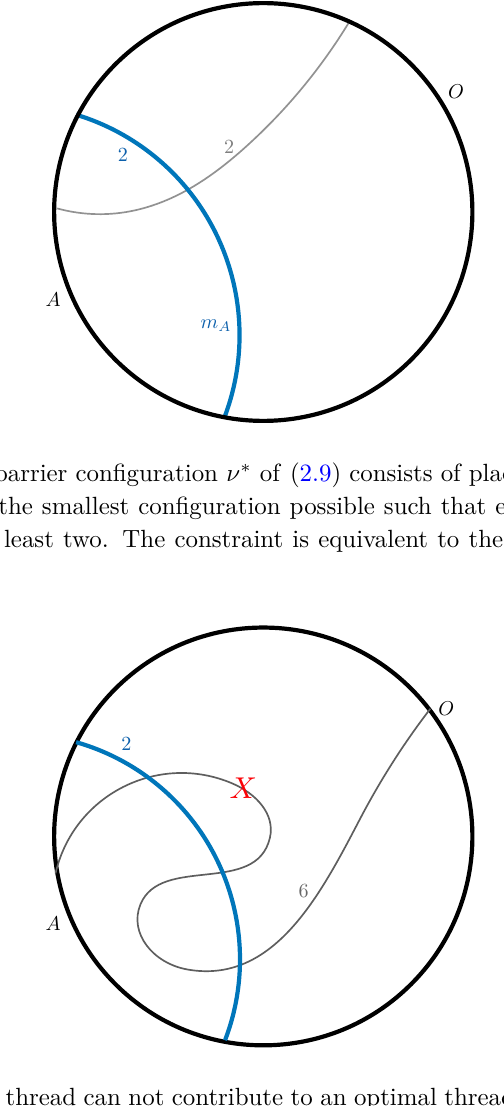
Figure 4 . The following thread can not contribute to an optimal thread configuration as it crosses a total barrier of six. This can be understood as the thread is highly inefficient with each additional crossing of the barrier further preventing other threads from being